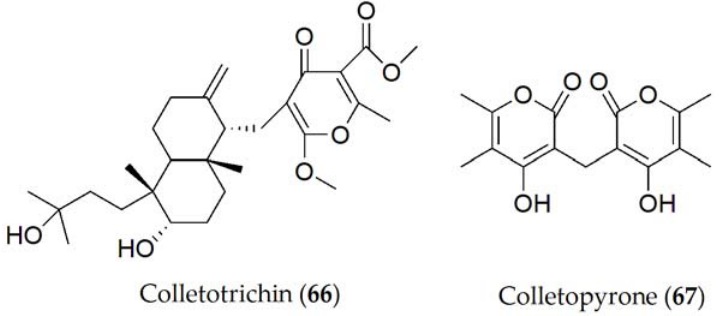
Figure 11. Phytotoxins isolated from Colletotrichum lindemuthianum .